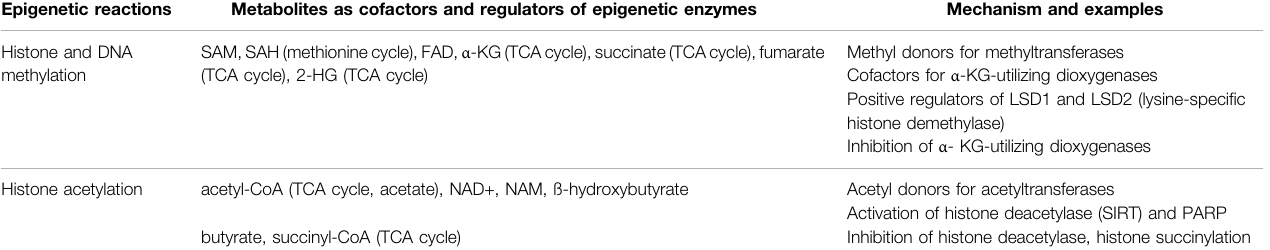
TABLE 1 | Main metabolic substrates and co-factors of epigenetic enzymes. Epigenetic reactions